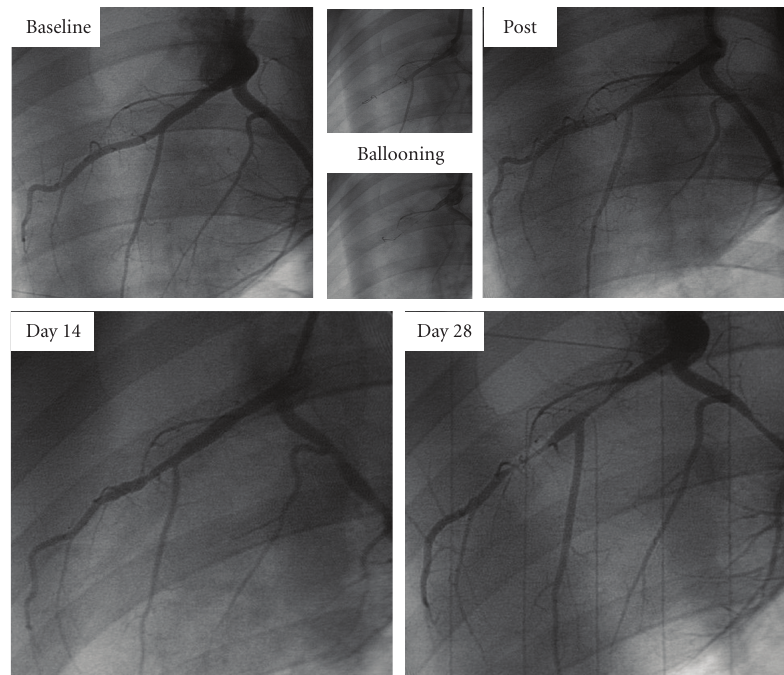
Figure 6: Time course of coronary artery treated with thermal balloon. A severe tandem coronary artery stenosis is observed in the left anterior descending artery (LAD) at 4 weeks after thermal balloon injury